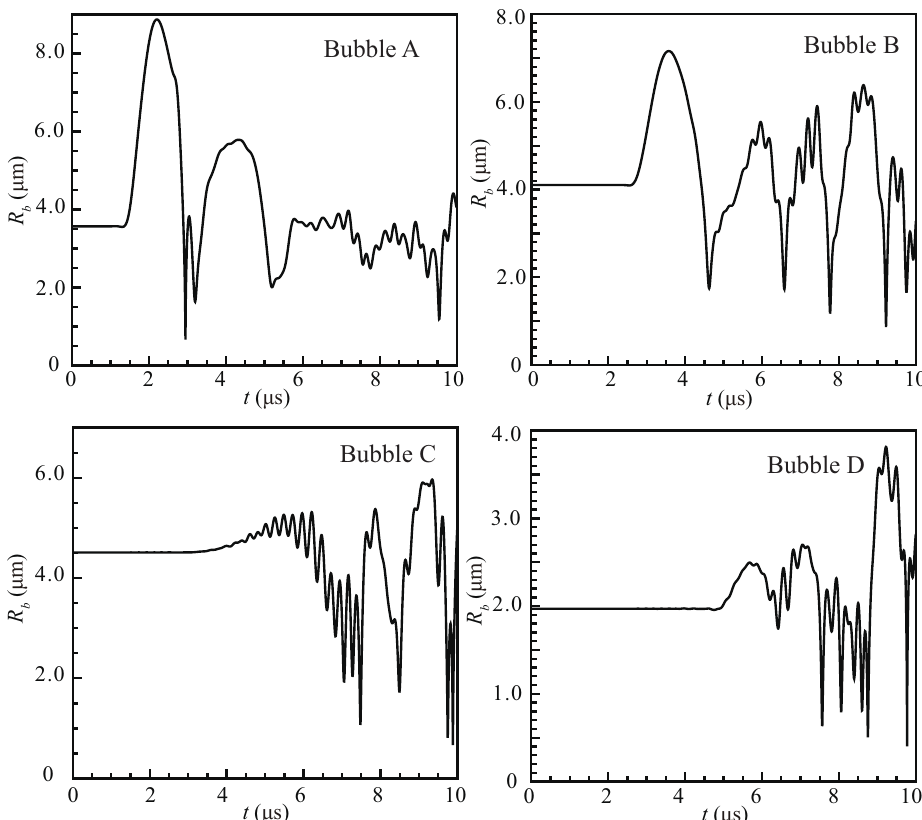
Figure 12. The time history of bubble radius R b of Bubble A (on the left side), Bubble B (on the bottom ), Bubble C (at bubble cloud center ), and Bubble D (on the right